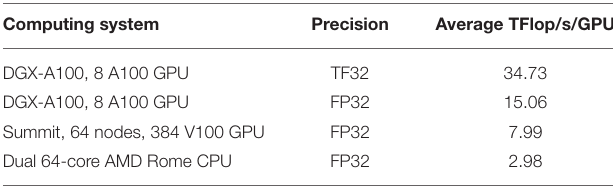
TABLE 3 | Average GPU performance in evaluation of a single amplitude of the 53-qubit Sycamore 2D random quantum circuit of depth